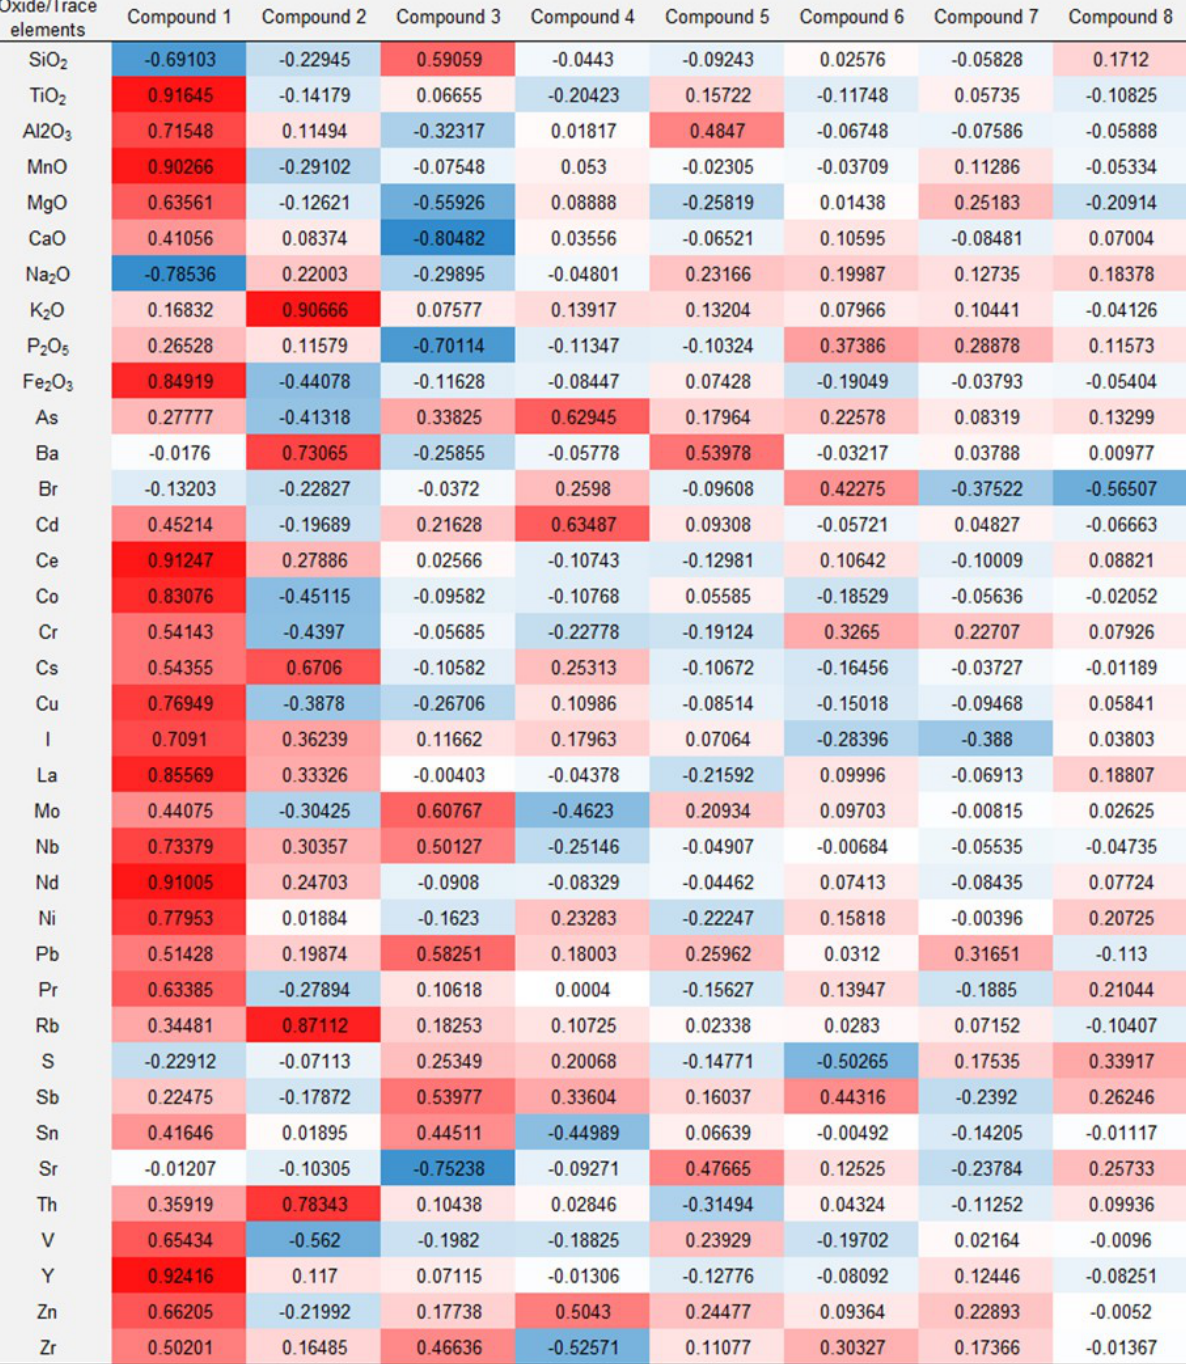
Table 4. Result of correlation between major and trace elements in soil of the Shuteen area. Red color indicates positive and blue color indicates a negative